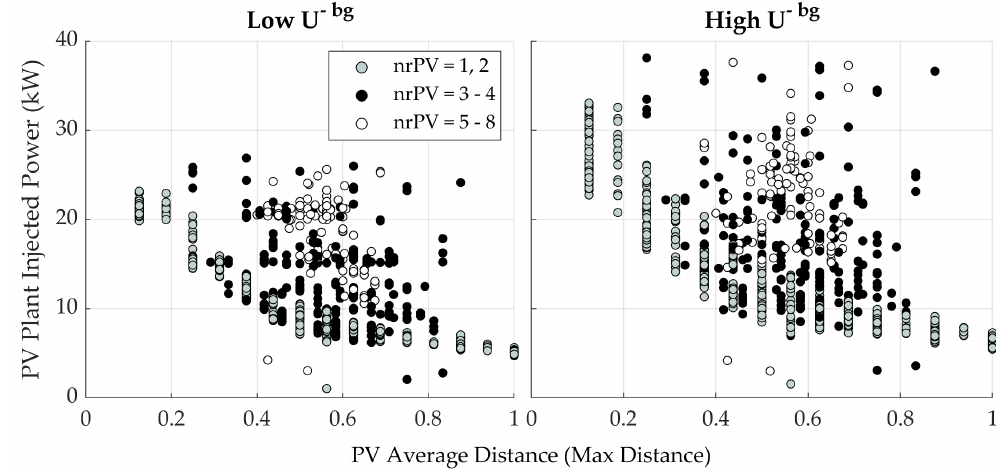
Figure 12. Maximum PV injection at different PV average distance from the